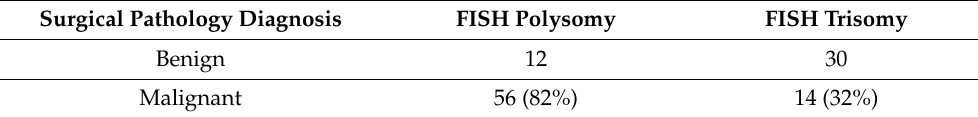
Table 5. Correlation of FISH-positive cases and final surgical pathology